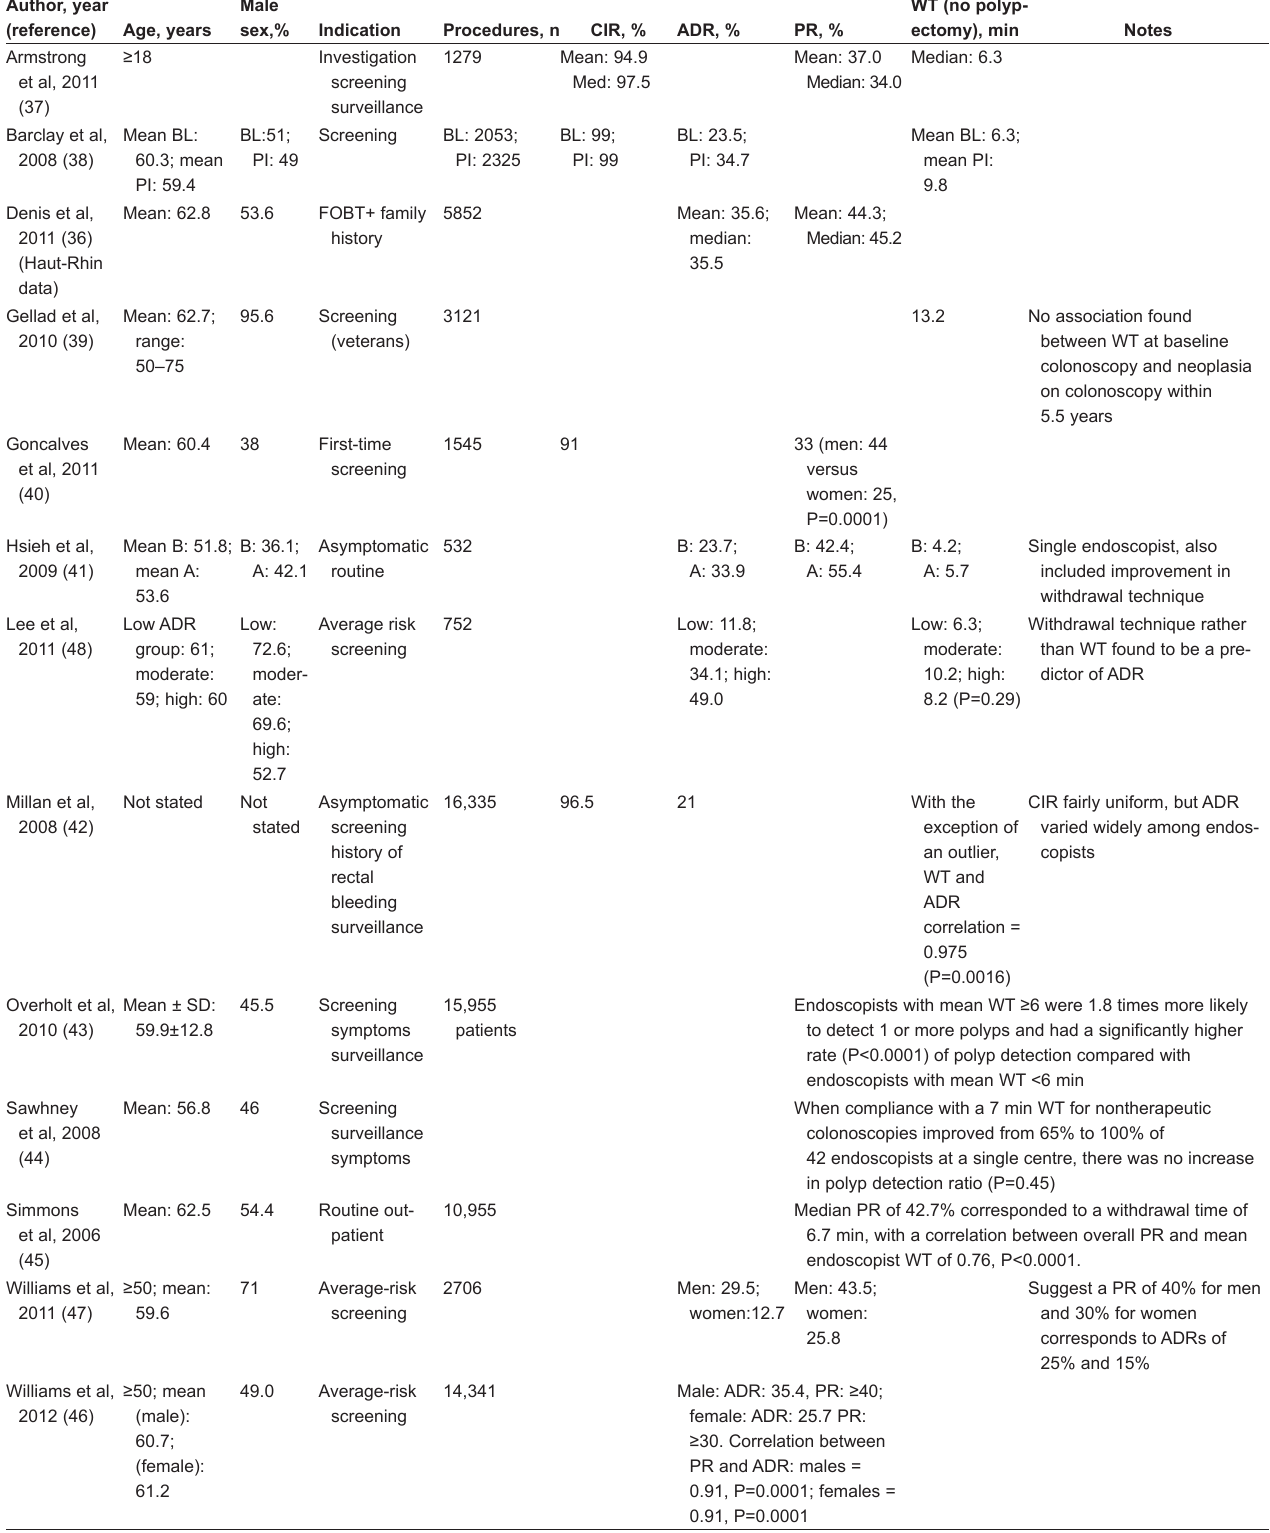
TAble 6 Study outcomes, cecal intubation rates (CIR), adenoma detection rates (ADR), polypectomy rates (PR) and withdrawal time